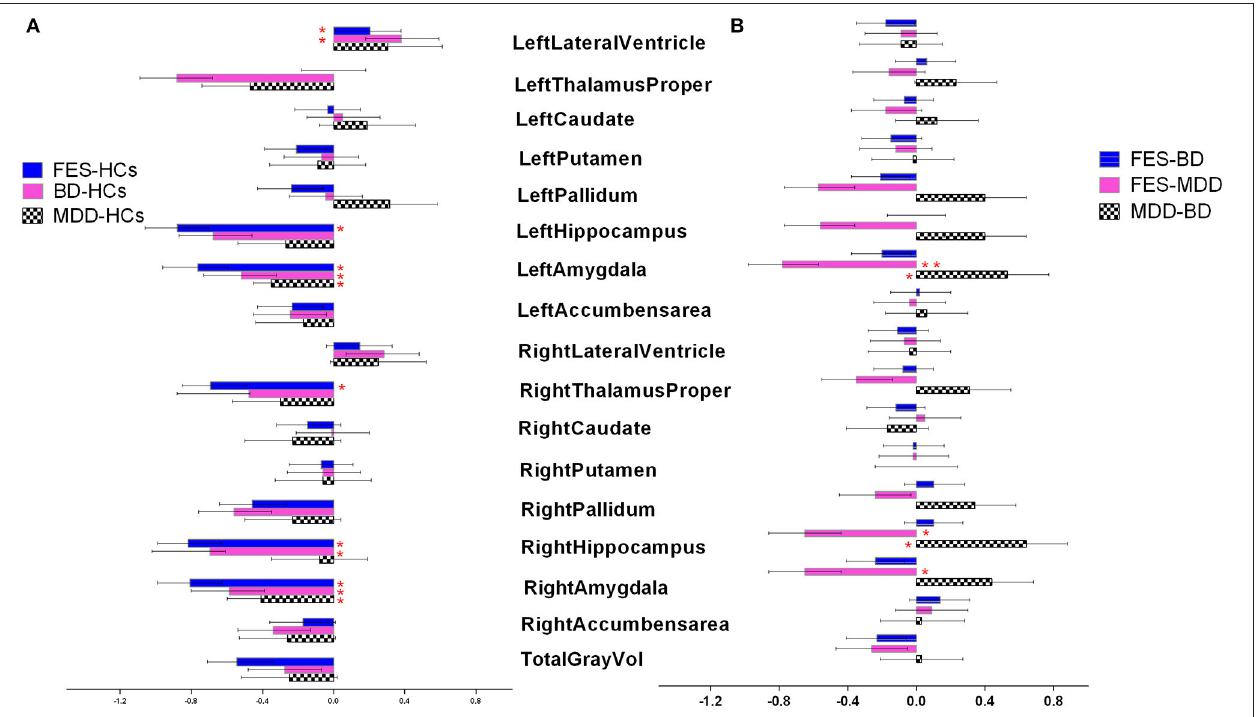
FIGURE 1 | (A,B) Cohen’s d effect sizes 95% CI and for regional brain volume differences. Effect sizes for all subcortical volumes depicted were corrected for age and intracranial volume (ICV). FES, first episode schizophrenia; BD, bipolar disorder; MDD, major depression disorder; HCs, healthy controls.